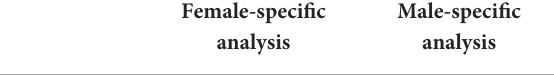
TABLE 2 Sex-specific cis-Mendelian randomization results (estimates for gene targets weighted by LDL cholesterol